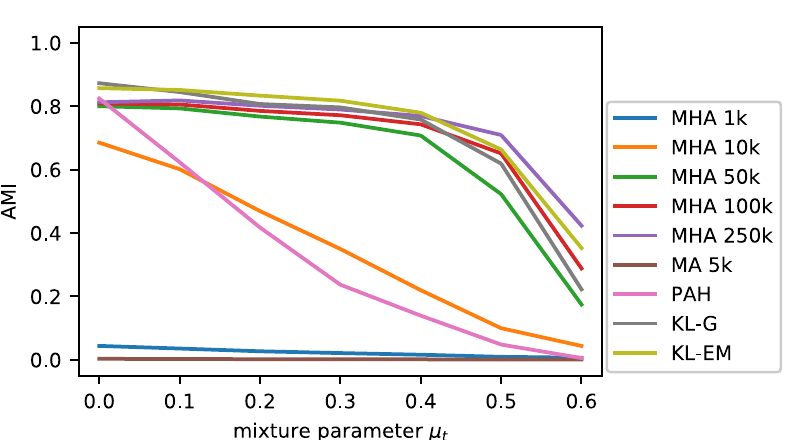
the mean of all executions with the same μ t and all SBM variants (of Fig 11). Fig 14 includes the results of selected inference algorithms for individual SBM variants.